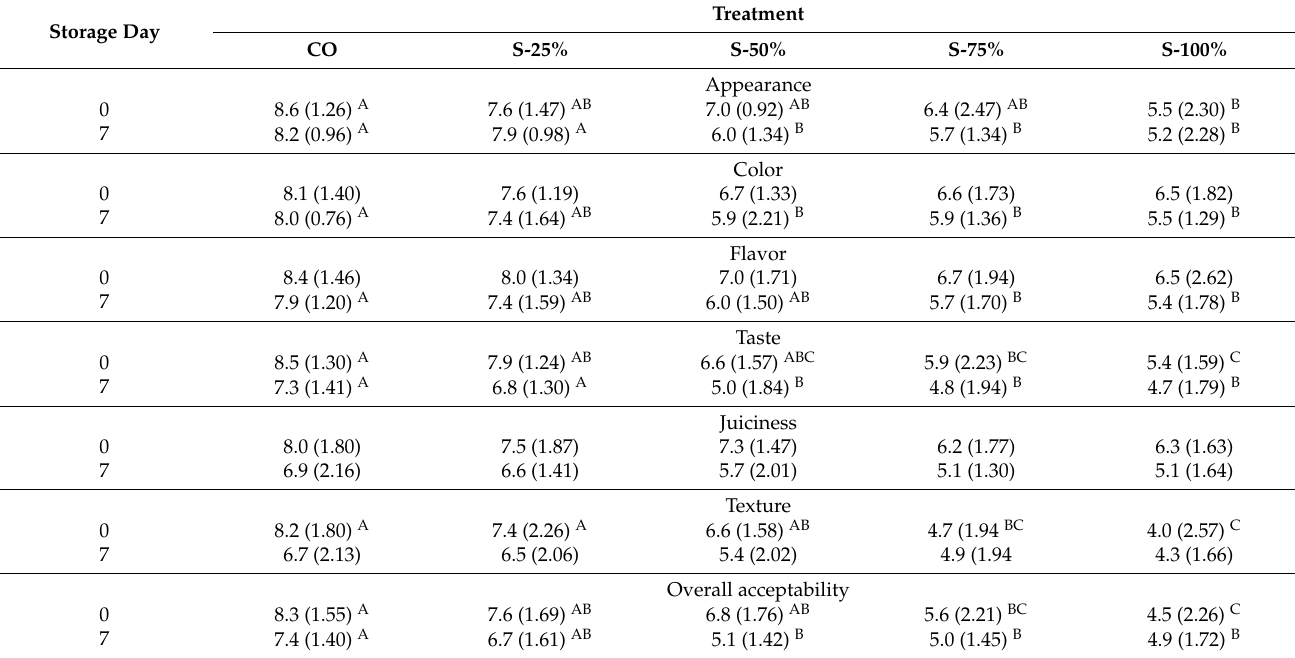
Table 3. Analysis of the effect of substitute fat on the sensory attributes measured on the 0 and 7 storage